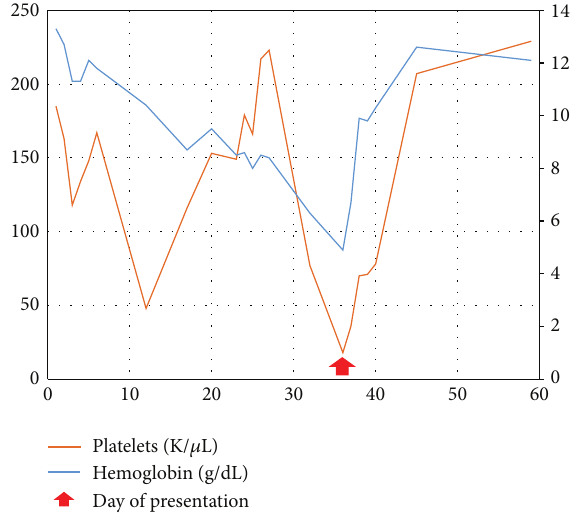
Figure 5: The patient’s hemoglobin and platelets are graphed in the days after initiating etoposide and ifosfamide. The minimum value of both parameters occurs on the day of presentation when retinal hemorrhage was